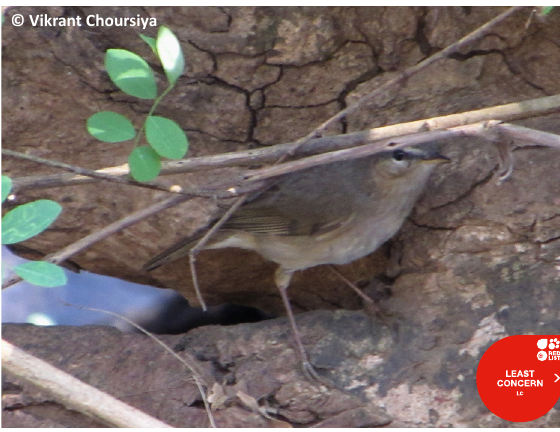
Image 1. An individual Dusky Warbler Phylloscopus fuscatus photographed on 15 December 2013 in Sanjay Gandhi National Park, Mumbai, Maharashtra,